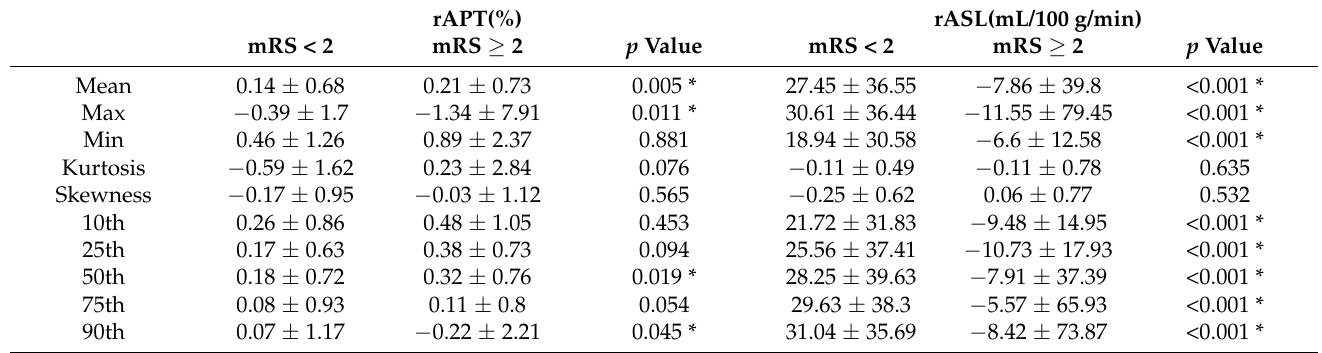
Table 3. The p -values for the comparison of histogram parameters between the group with low mRS and the other group. Values are mean ± standard deviations.